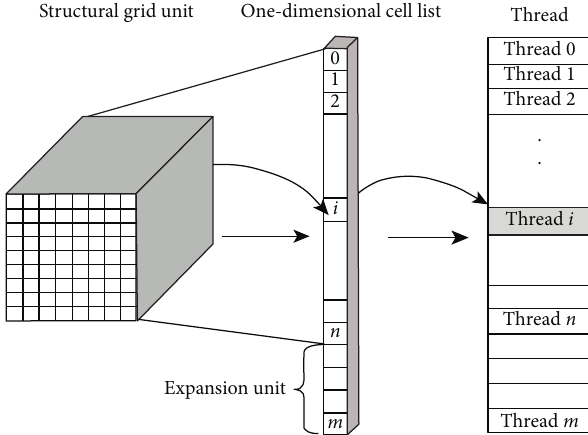
Figure 2: Thread mapping of structural grid unit